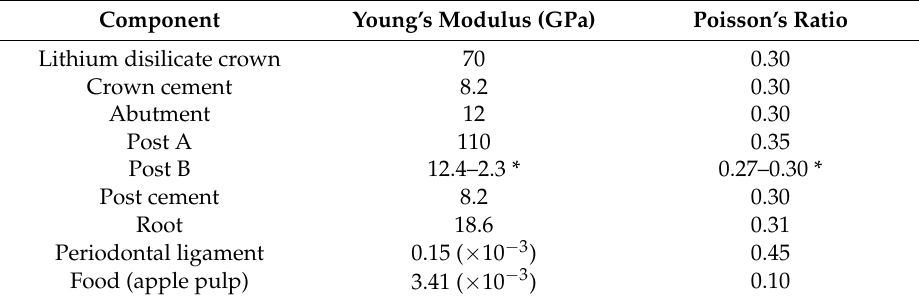
Table 2. Young’s modulus and Poisson’s ratio for the components of the tooth model [16]. * The values varied from the coronal to the apical part of the part according to the different regions [17] of the proposed multilayer